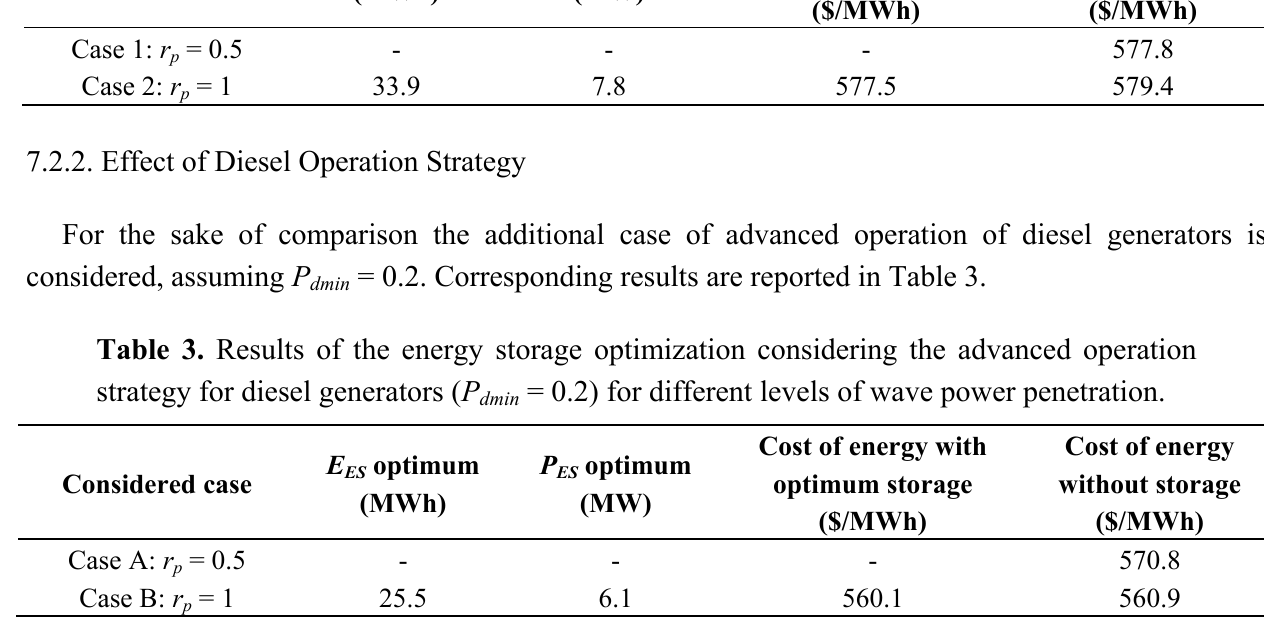
= 0.3 ) for different levels of wave dmin